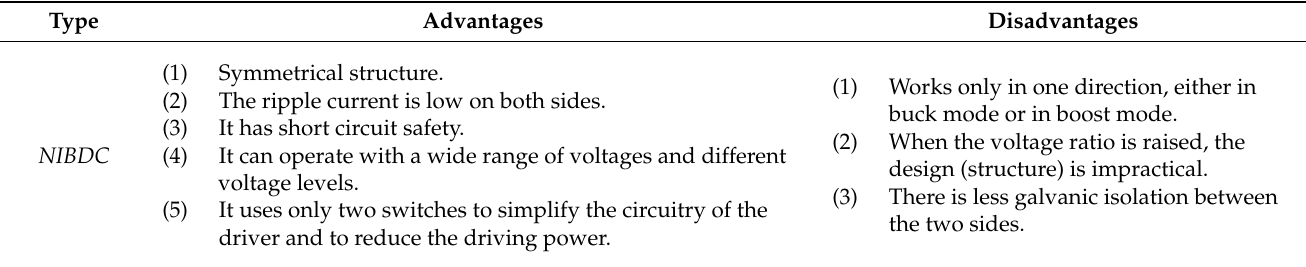
Table 1. Pros and cons of NIBDC and IBDC bidirectional DC-DC